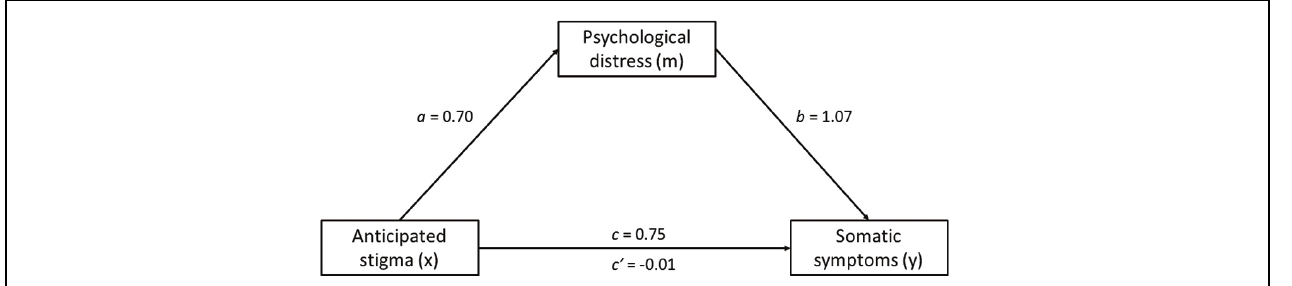
FIGURE 1 | Mediation of the effect of anticipated stigma on somatic symptoms by psychological distress.